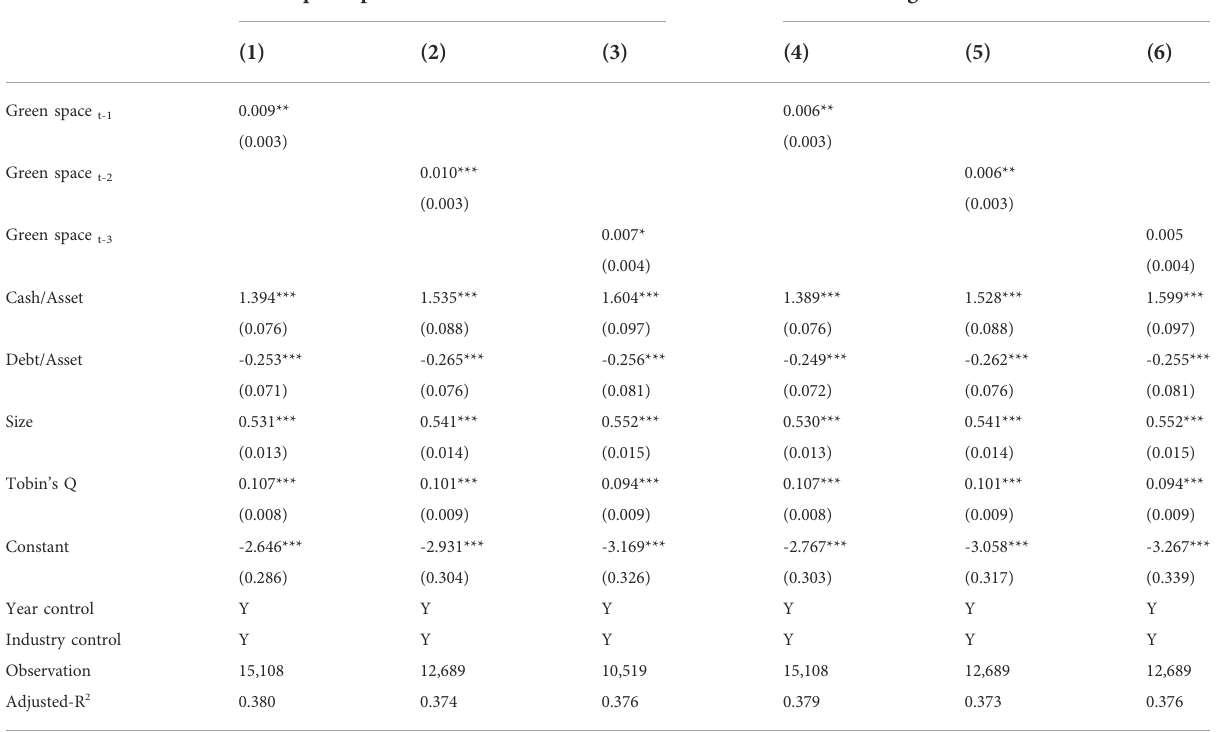
TABLE 4 The lagged effect of green spaces construction on fi rms ’